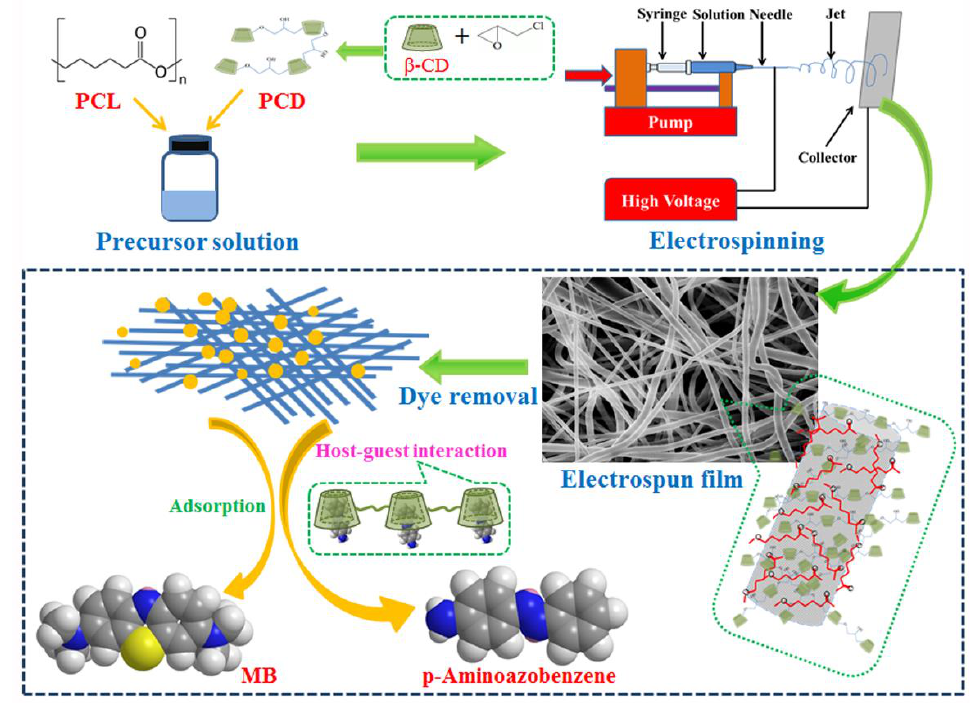
Figure 1. Schematic illustration of preparation and application in dye removal of PCL/(n%)PCD composite fibers by electrospinning.